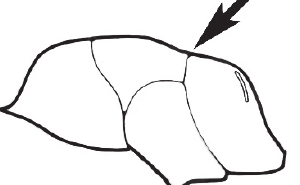
of Melophorus propebiroi ) .......................................................................... 47